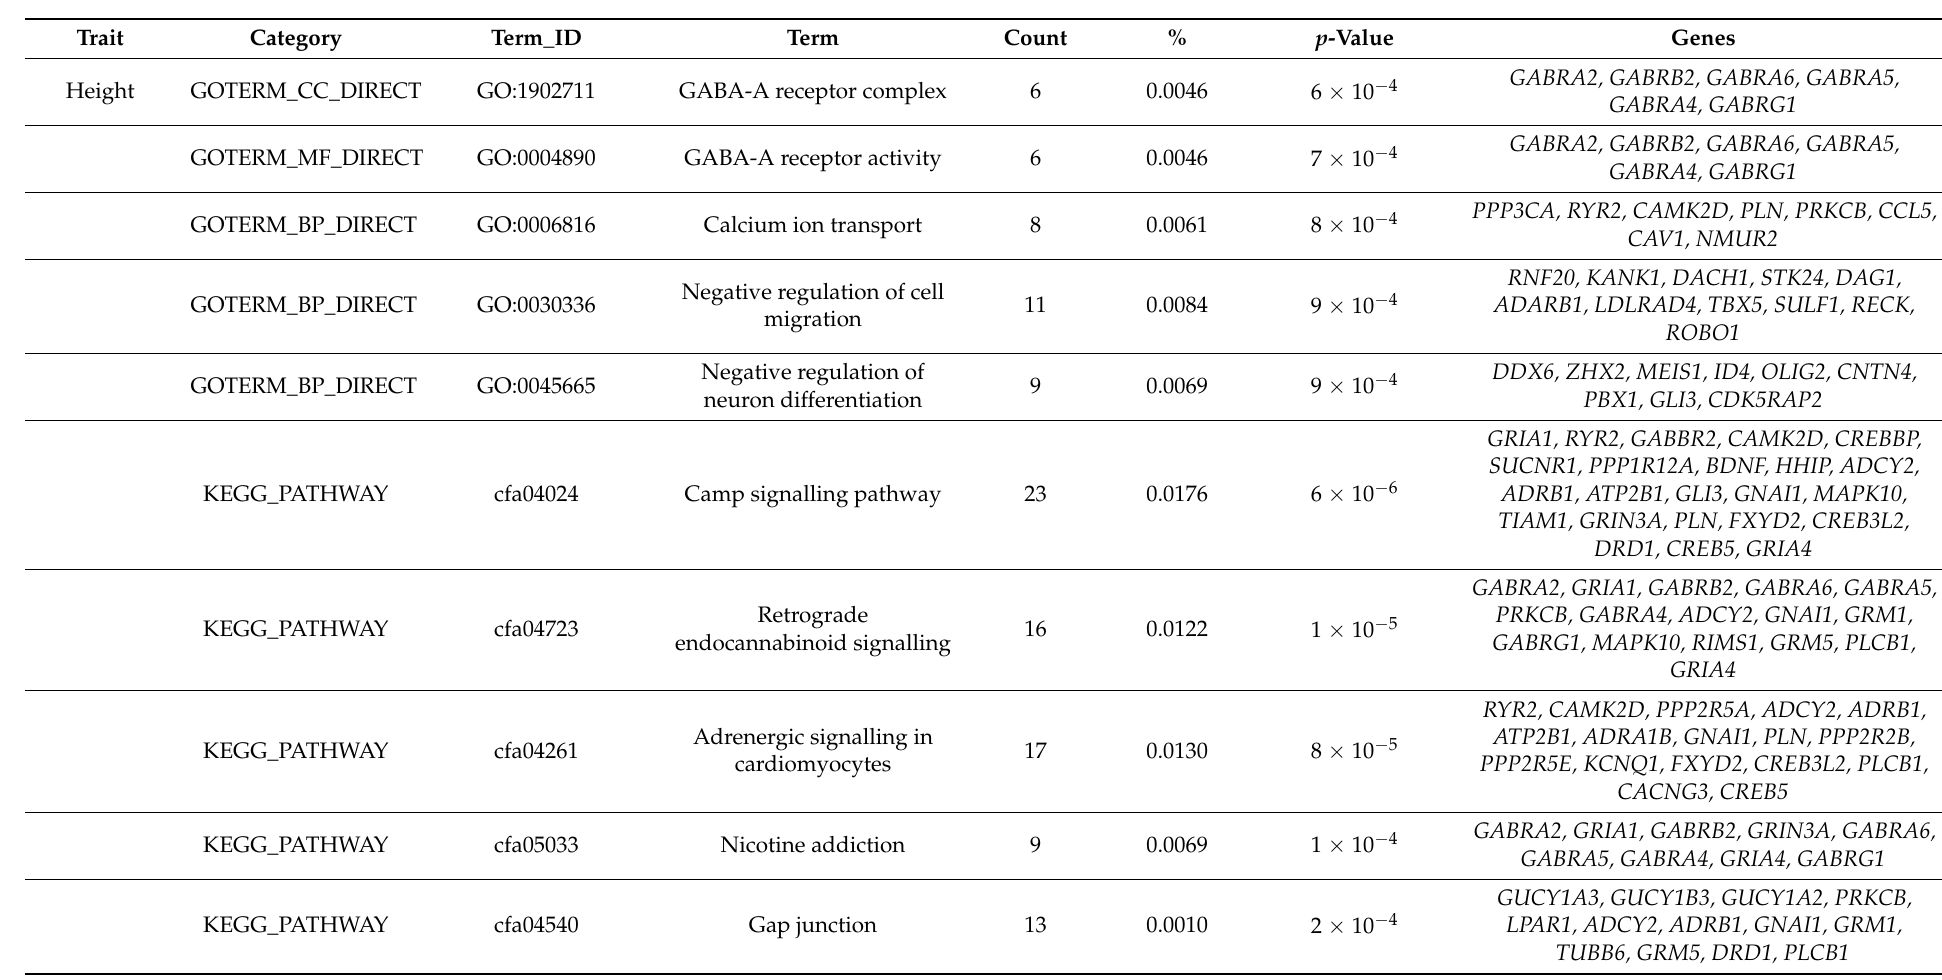
Table 4. Top five Gene Ontology and KEGG pathways significantly enriched using genes associated with height, length, LHR and body